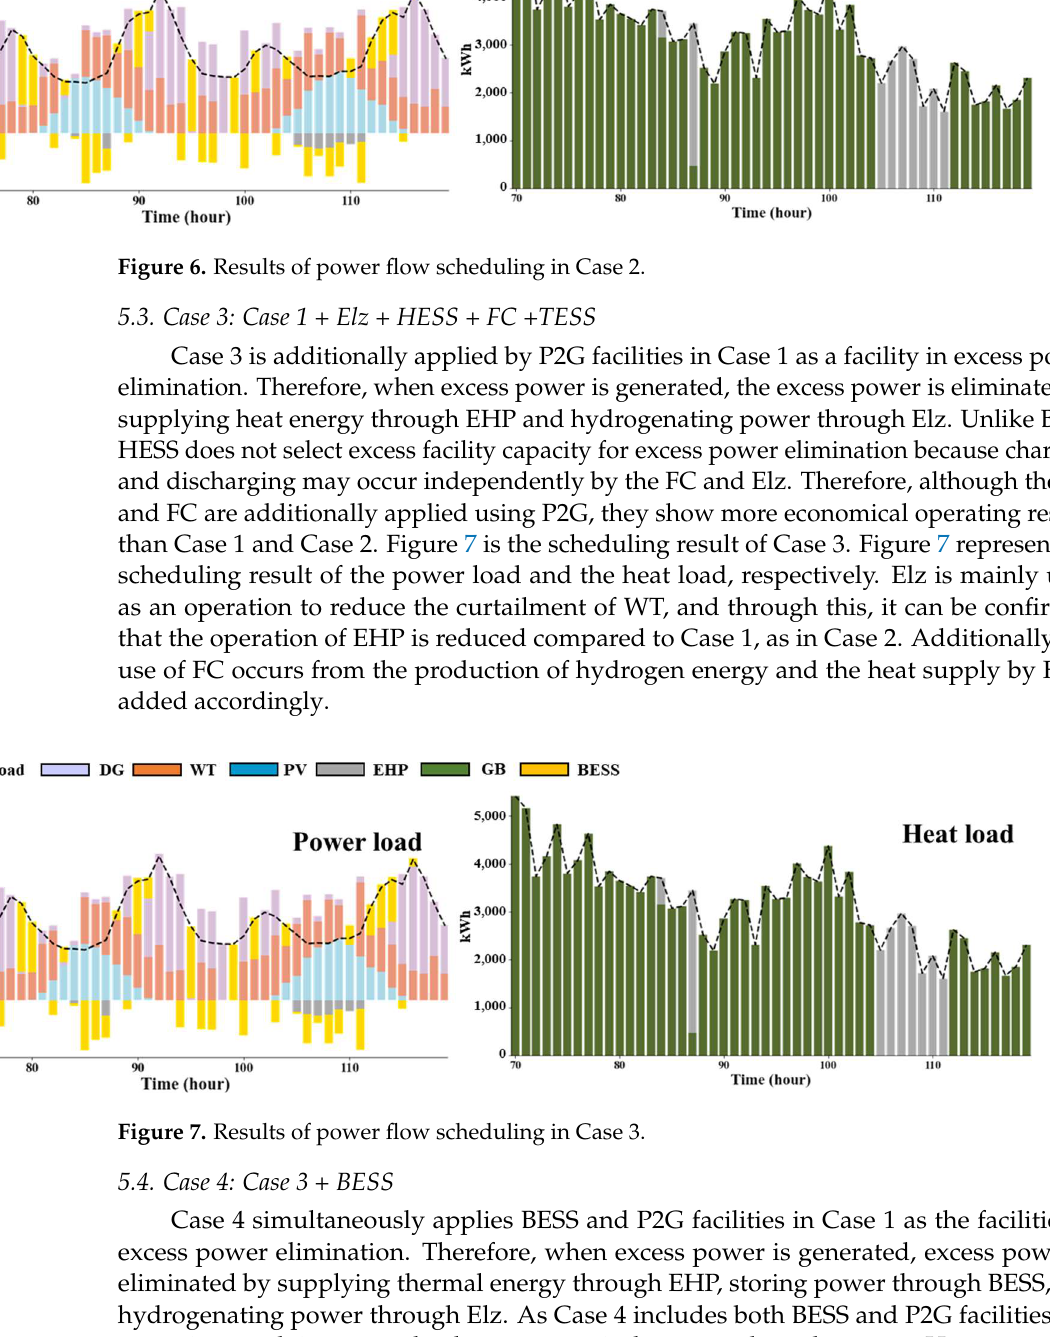
Figure 7. Results of power flow scheduling in Case 3. 5.4. Case 4: Case 3 + BESS Case 4 simultaneously applies BESS and P2G facilities in Case 1 as the facilities in excess power elimination. Therefore, when excess power is generated, excess power is eliminated by supplying thermal energy through EHP, storing power through BESS, and hydrogenating power through Elz. As Case 4 includes both BESS and P2G facilities, the operation result is expected to be uneconomical compared to other cases. However, when excess power occurs in the simulation, the capacity of each facility is moderately selected through a complementary operation. Through this, the most economical IES design and operation results are derived while reducing the same level of curtailed power in all cases. Figure 8 is the scheduling result of Case 3. Figure 8 represent the scheduling result of the power load and the heat load, respectively. In Case 5, Elz and BESS are simultaneously used as an operation to reduce the curtailment of WT. Through this, it can be confirmed